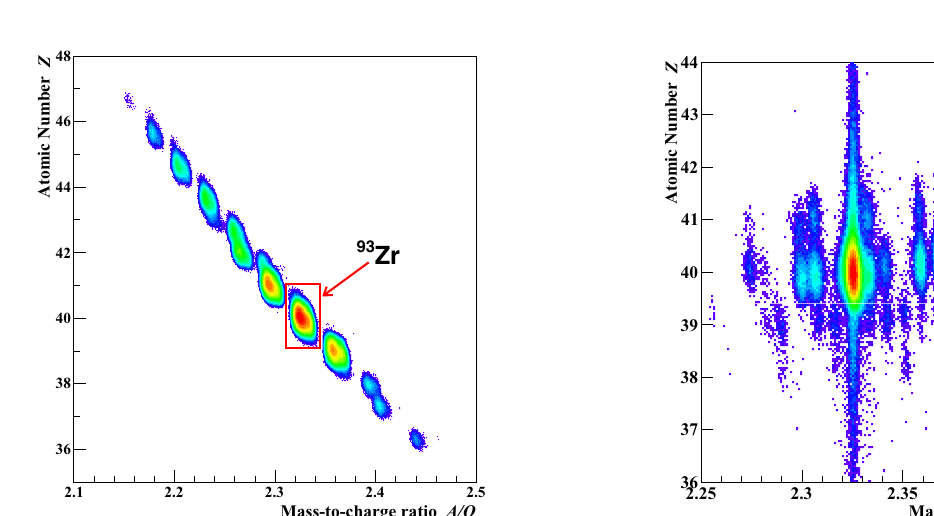
Figure 1. Particle identification plot for the secondary beam. The red box outlines the 93 Zr beam.